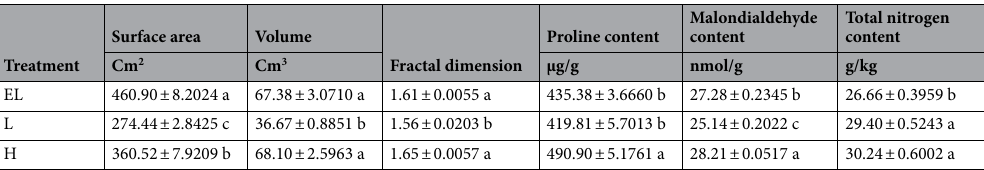
Table 1. Nitrogen starvation and excess stress effects on the root morphology and physiology of walnut seedlings. The first column lists the different treatments (L = control, EL = nitrogen starvation, H = nitrogen excess), while the top row shows the indicators and the second row shows the indicator units. The data are the means ± SE. Different letters indicate statistical significance between the treatments tested by the analysis of variance (P <